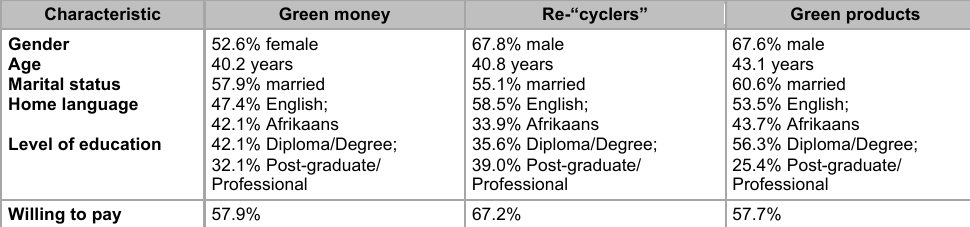
Characteristics of cyclists by their green views